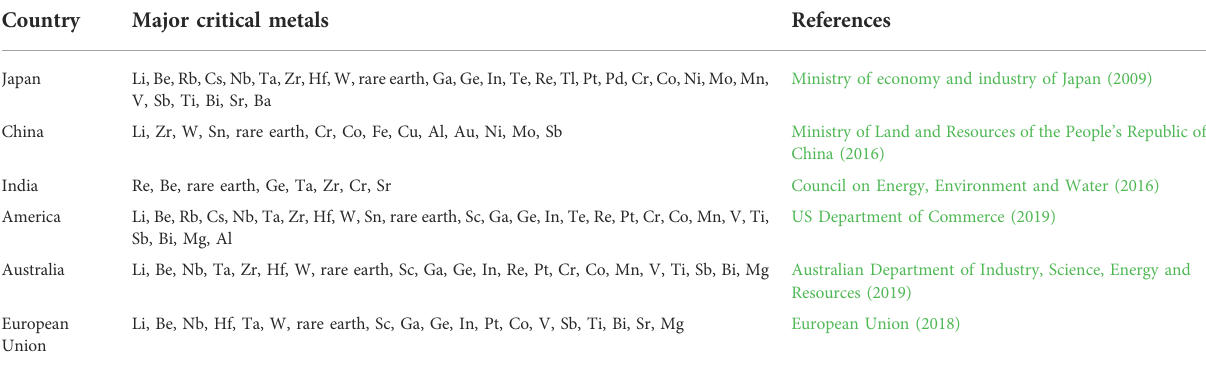
FIGURE 1 Literature review of critical metals.